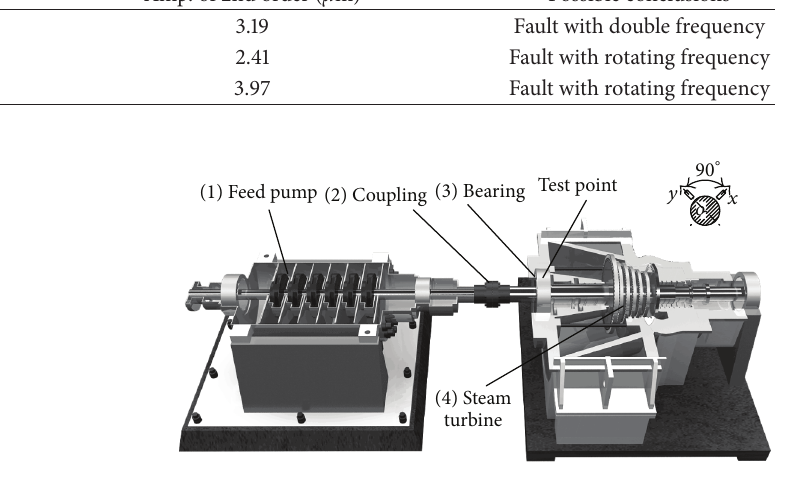
Figure 8: Machine structure and point